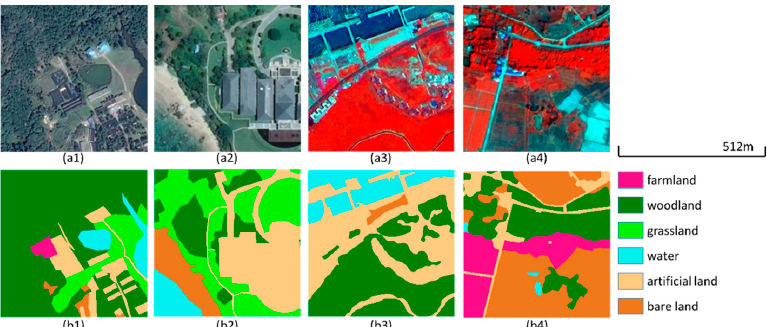
Figure 2. Examples for datasets A and B. ( a1 , a2 ) True color images. ( a3 , a4 ) False color composites of the near-infrared, green, and blue bands (NIR, G, B). ( b1 – b4 ) Corresponding